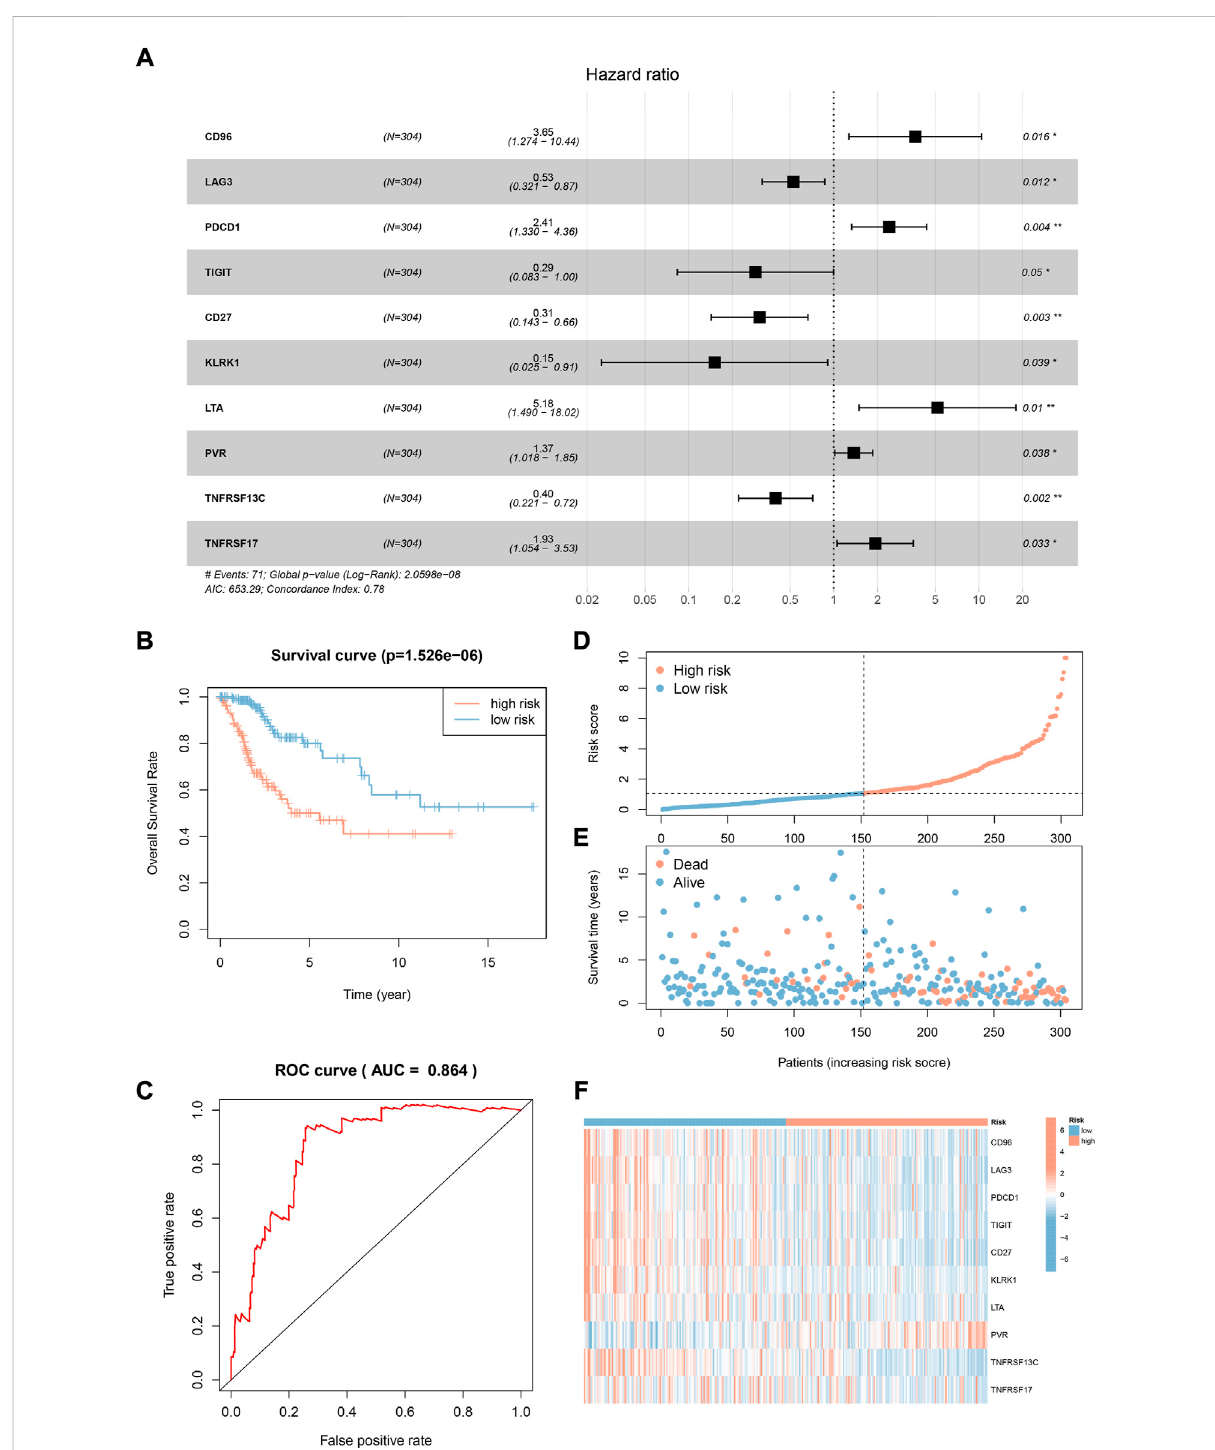
FIGURE 7 Construction and validation of a prognostic signature based on CD79B-associated immunomodulators. (A) The hazard ratios of the 10 genes used to establish the prognostic signature. (B) Kaplan-Meier curve between the high-risk-score and low-risk-score groups from the CESC cohorts ( p = 1.526e-06). (C) ROC curve describing the predictive accuracy of the prognostic signature in the CESC cohorts. (D) Distribution of risk scores in the CESC cohorts. (E) Survival status of CESC patients in the low-risk and high-risk groups. (F) Expression pro fi le of 10 CD79B-associated immunomodulatory genes from the CESC